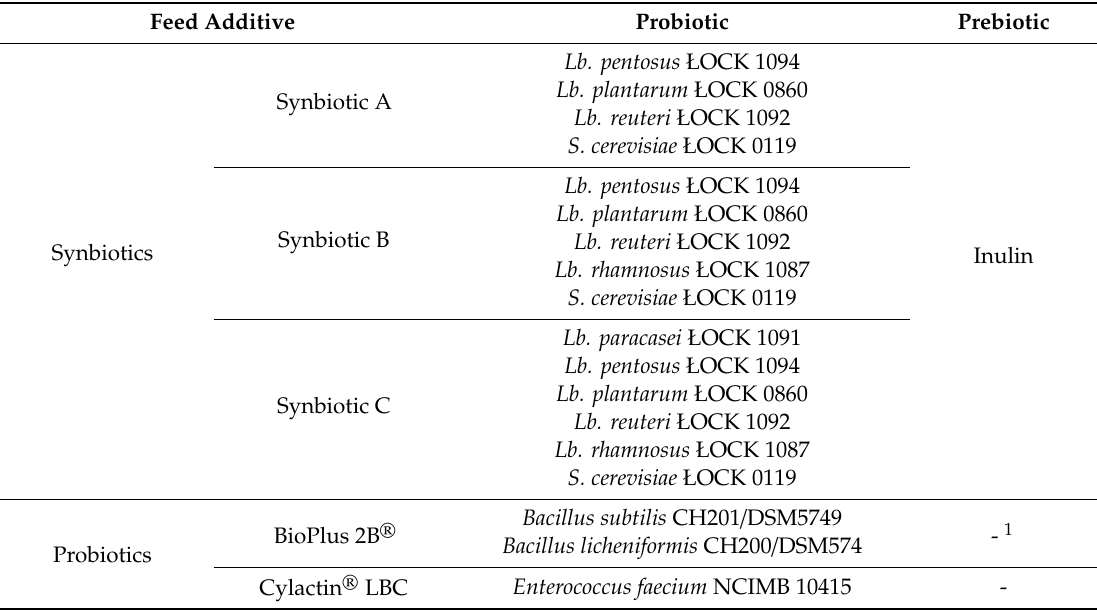
Table 1. Analyzed probiotics and synbiotics